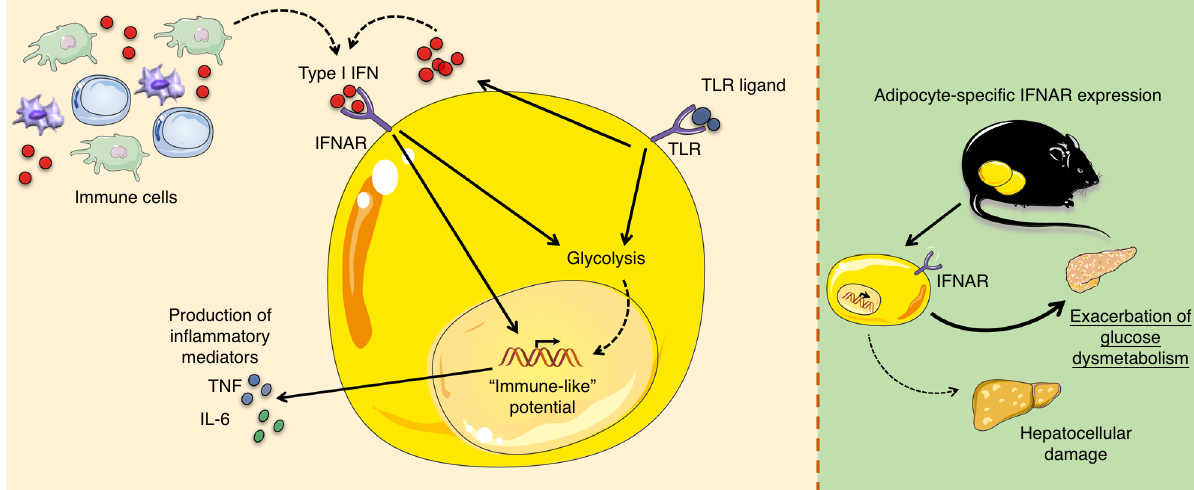
Fig. 8 Type I IFN/IFNAR axis is a regulator of adipocyte-intrinsic in fl ammatory potential. A proposed model of how type I IFN/IFNAR axis unlocks adipocyte in fl ammatory vigor, through modulation of adipocyte core metabolism. Adipocyte-speci fi c IFNAR expression modi fi es the severity of obesity- associated glucose dysmetabolism in mice with limited impact on hepatocellular damage. Source data are provided as a Source data fi